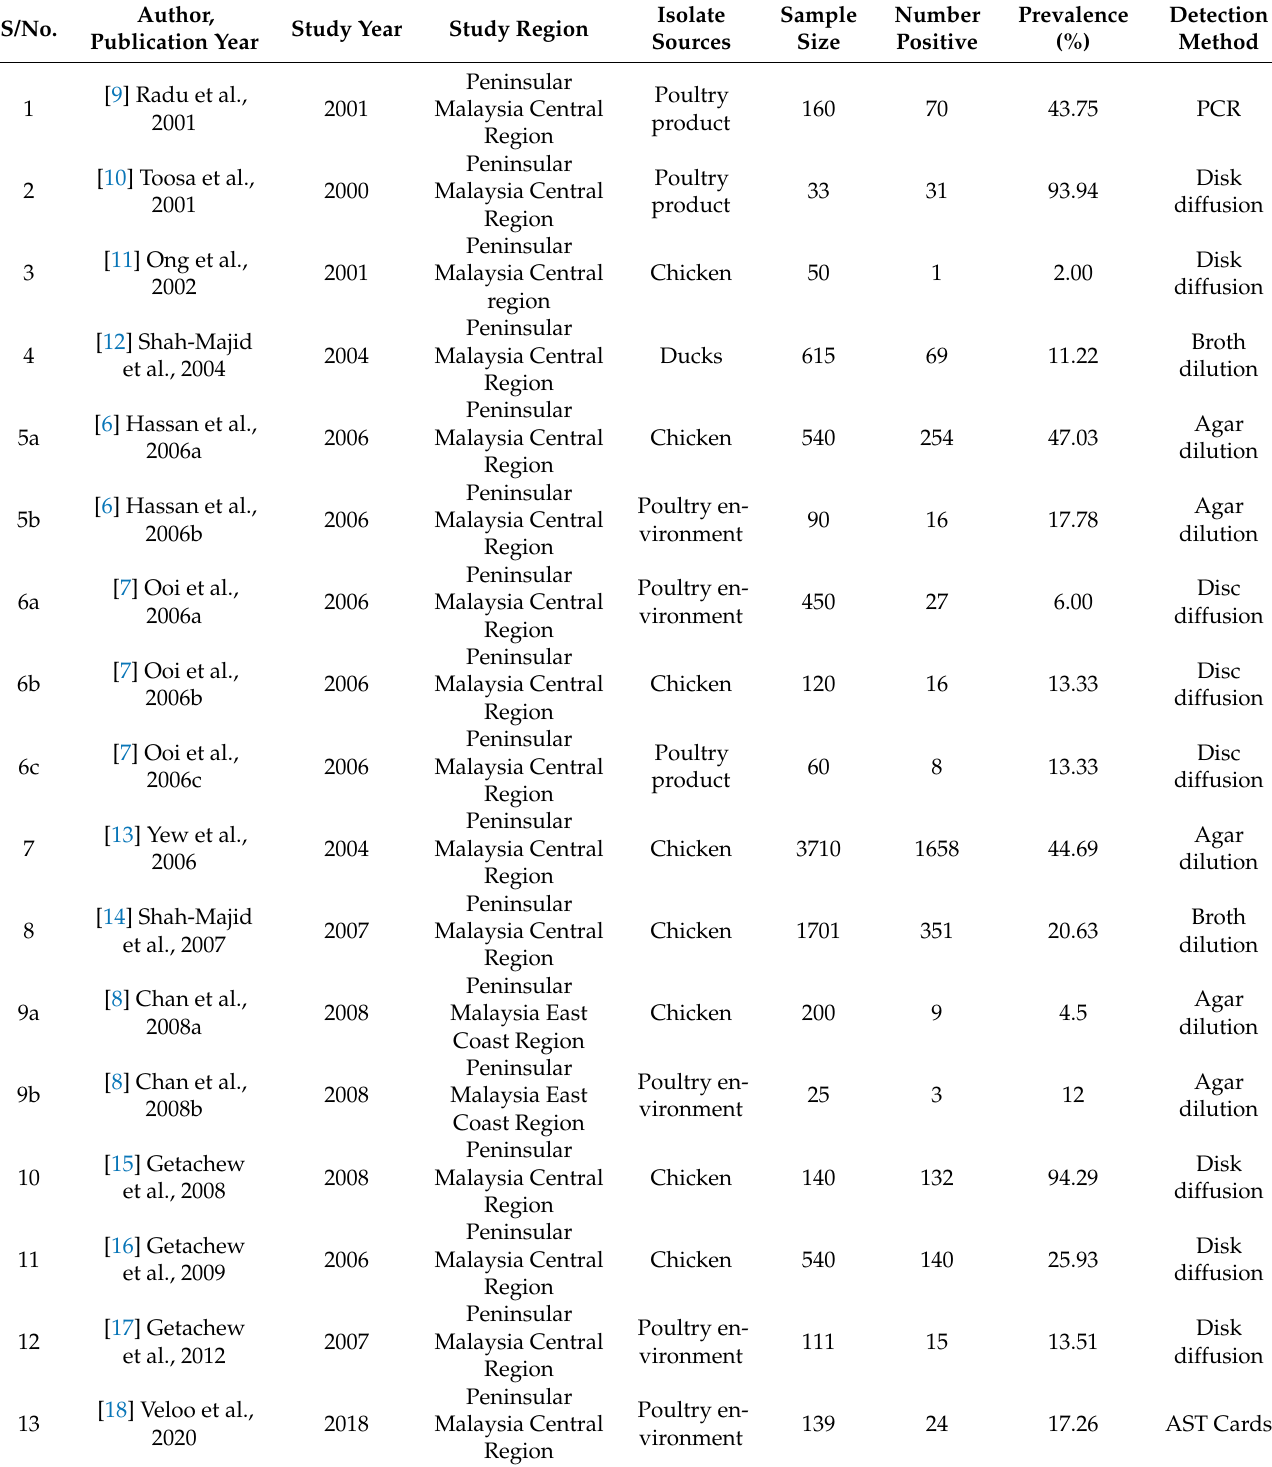
Table 1. Characteristics of included studies reporting the prevalence of vancomycin-resistant entero- coccus in poultry in